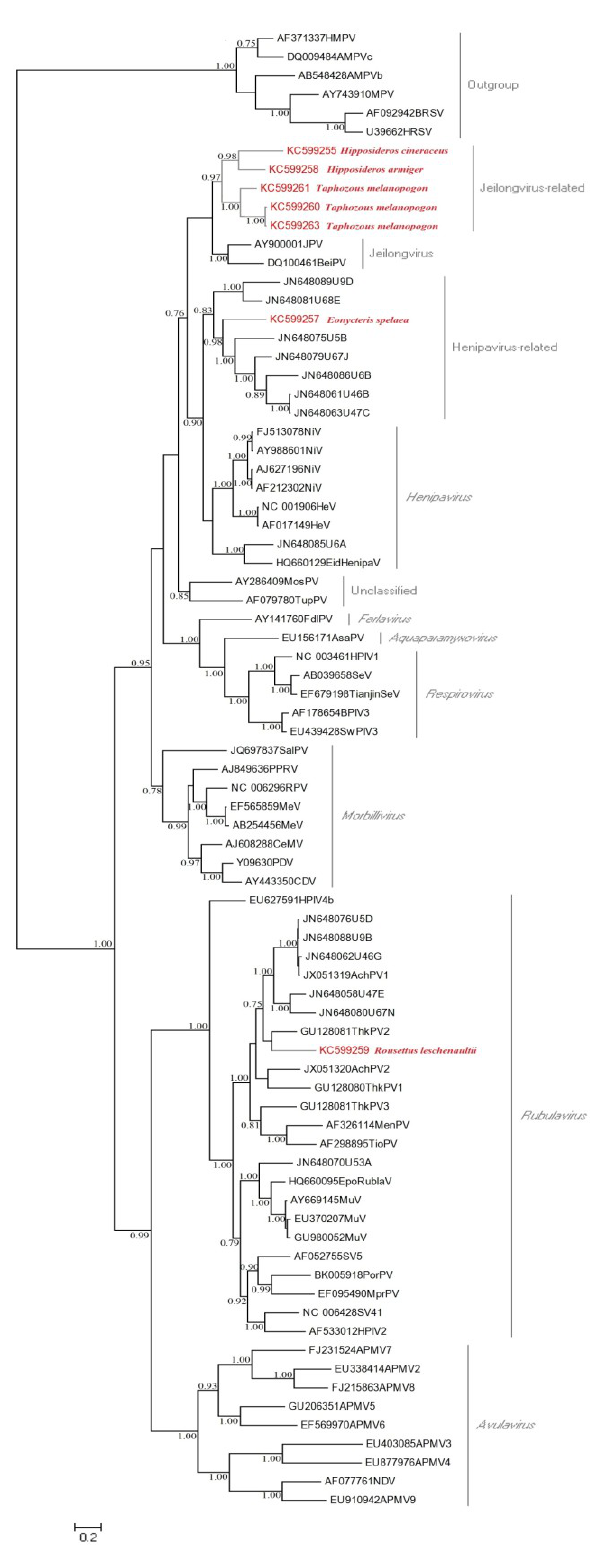
Figure 1. Phylogenetic analysis of paramyxovirus L-gene identified by RT-PCR. Phylogenetic tree of paramyxoviruse L-gene was constructed based on a 529 bp sequence alignment with Pneumovirinae subfamily as an outgroup. The accession numbers of sequences identified in this study are red and posterior probability values are shown next to the tree nodes. Posterior probability values are shown at each node (>70%) and the bar represents the expected number of amino acid substitutions per